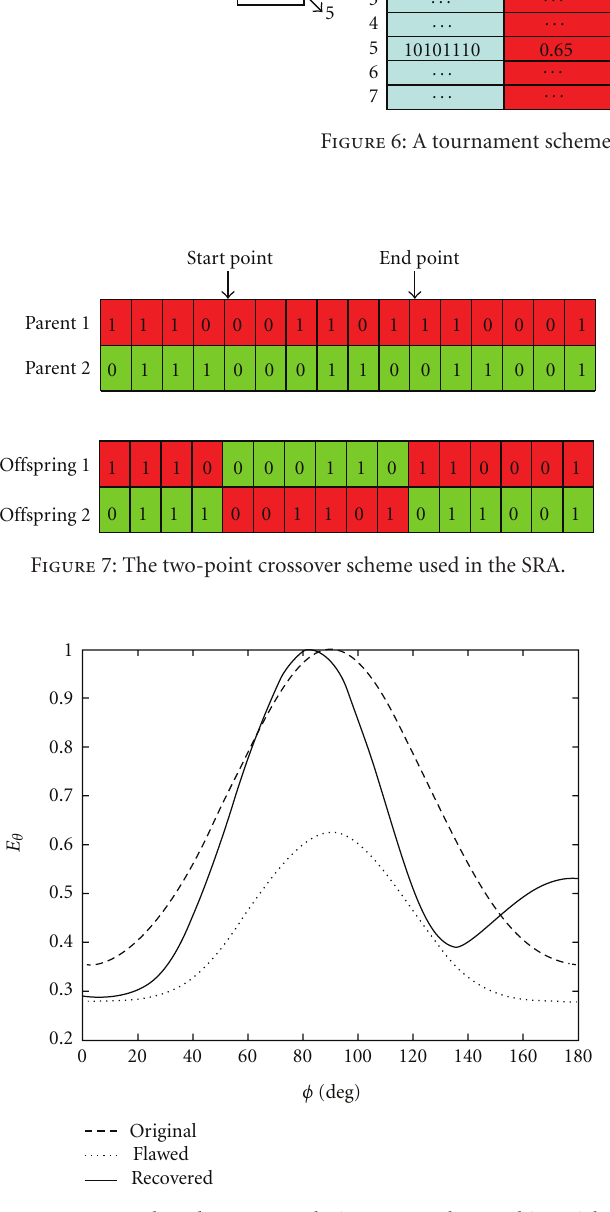
Figure 8: A PC-based recovery solution to a 4-element binomial linear array when run over 60 generations with the population size of 60 chromosomes.